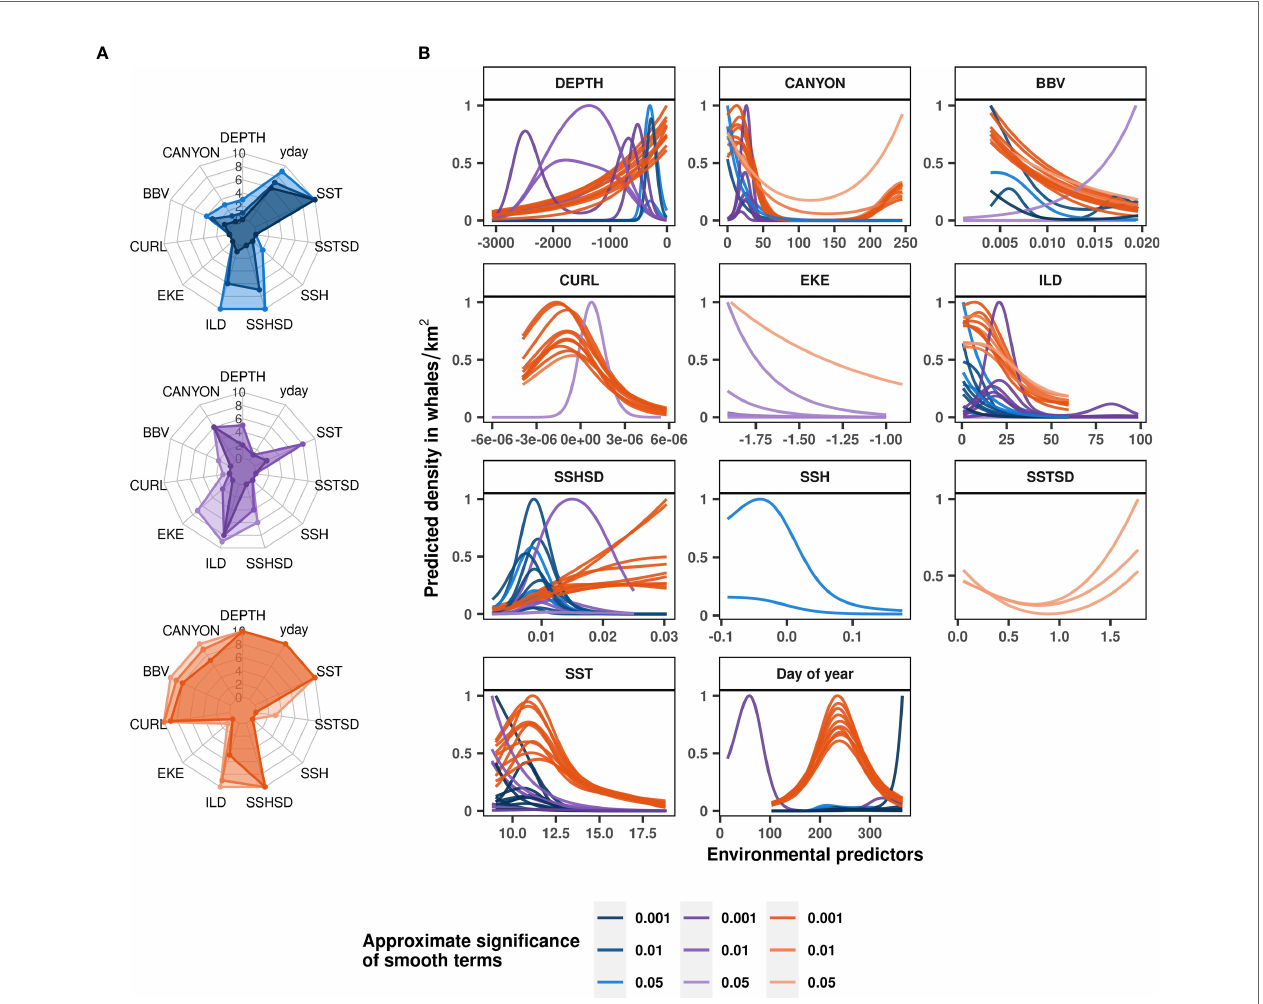
FIGURE 5 | Blue, fi n and humpback whale ecological relationships modelled with Mbl (in blue), M fi (in purple) and Mhb (in orange) respectively. Variable contributions to species-speci fi c models illustrated as radar plots (A) are measured by the number of cross-validation folds in which the approximate smooth signi fi cance p-values were below 0.05, 0.01 or 0.001 (shown with increasingly dark color shades). Functional response curves (B) represent the effect of the smooth function of environmental variables upon the trend in rorqual density, with higher values indicating higher predicted densities. Solid lines represent the marginal effect of each variable relative to whale density per cross-validation fold. Only the contributors with approximate smooth signi fi cance p-value < 0.05 are shown per model fold. Environmental variables: day of year (yday), distance to canyons (CANYON in km), seabed depth (DEPTH in m), sea surface temperature (SST in °C) and its spatial standard deviation (SSTSD calculated over 0.3° squares), sea surface height (SSH in m) and its standard deviation (SSHSD calculated over 0.3° squares), eddy kinetic energy (EKE calculated from eastward and northward surface current velocities, kg·m 2 ·s − 2 ), wind stress curl (CURL in Newton.m -3 ), isothermal layer depth (ILD in m) and bulk buoyancy frequency (BBV in s -1